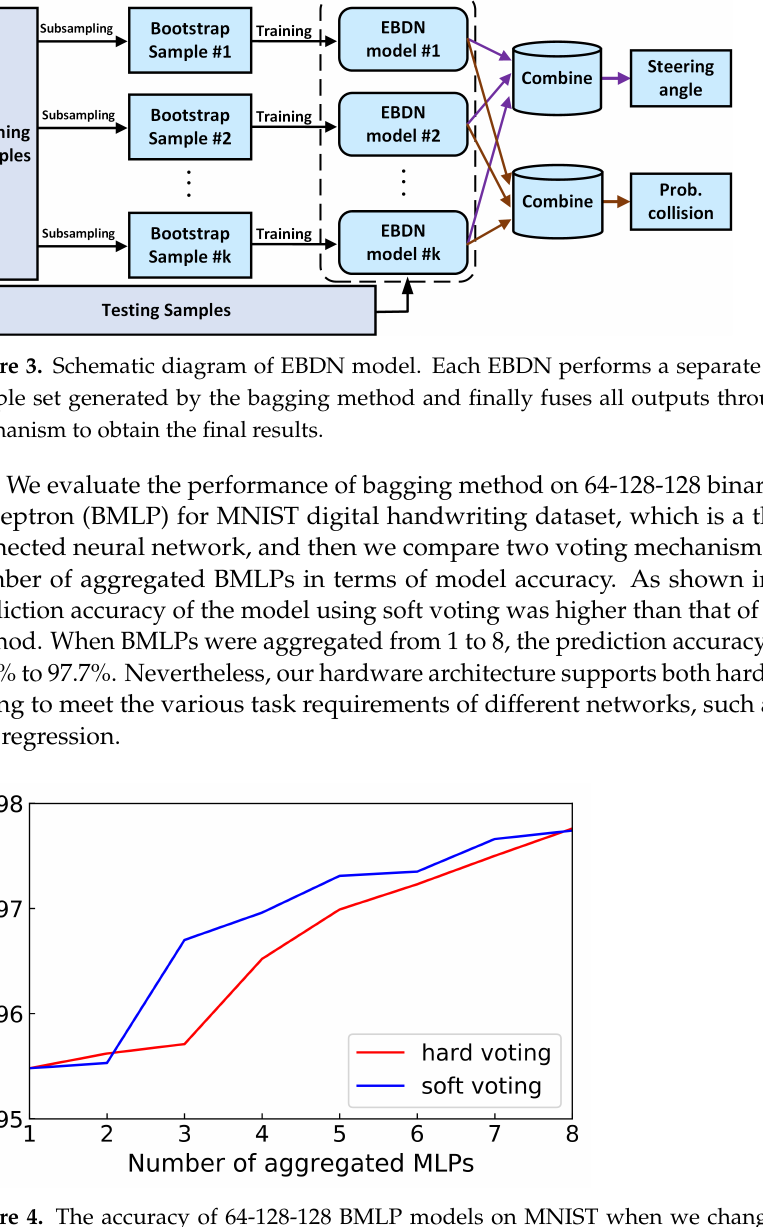
Figure 4. The accuracy of 64-128-128 BMLP models on MNIST when we change the number of aggregated BMLPs from 1 to